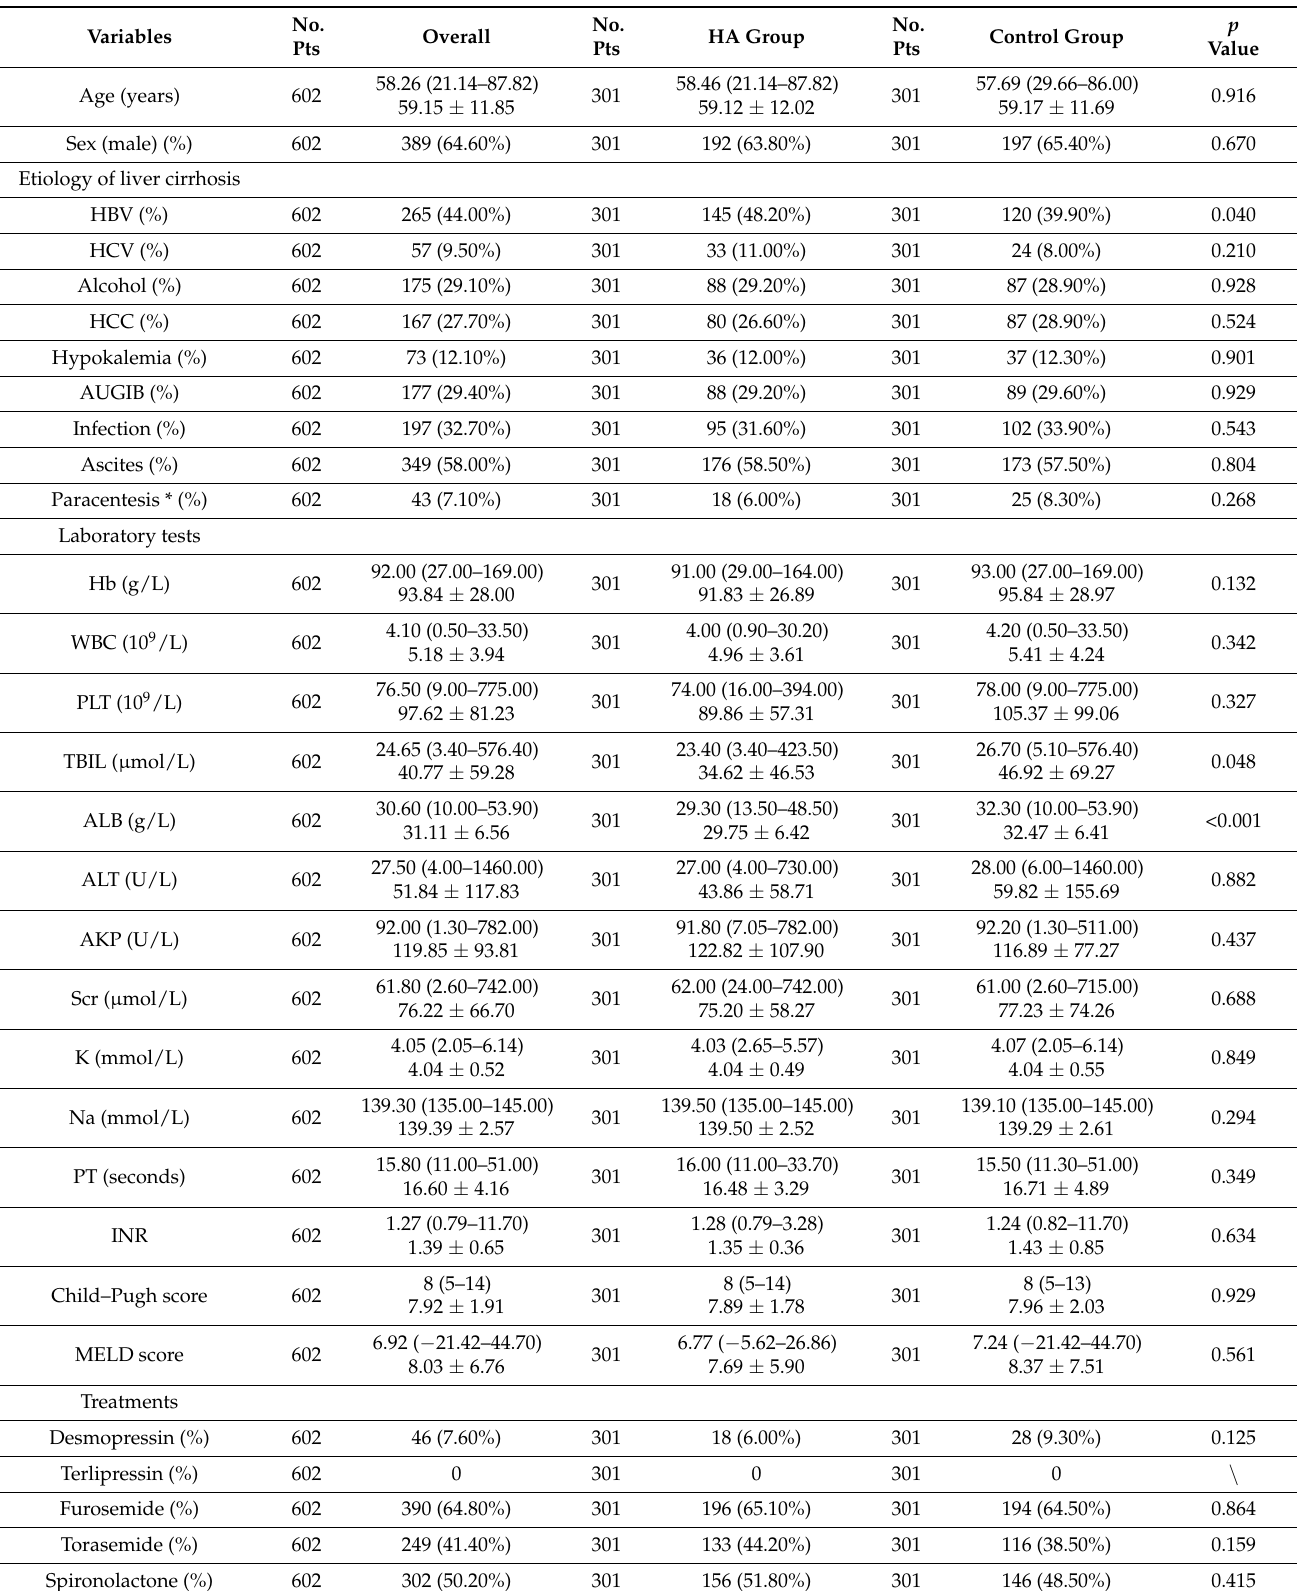
Table 1. Hospitalization outcome cohort—Characteristics of patients in the prevention study after